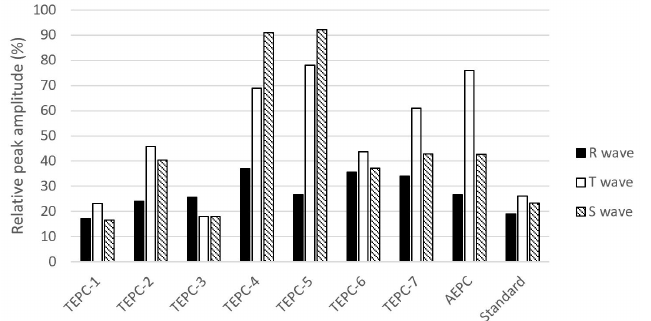
Figure 8. Calculated ratios of differences between the minimum and maximum peak values of R, S, and T waves from the maximum peak values.